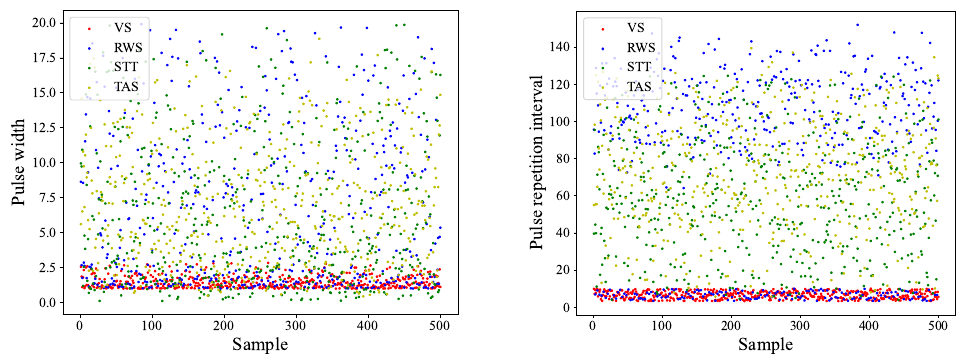
Figure 12. Overlapping of behavior mode